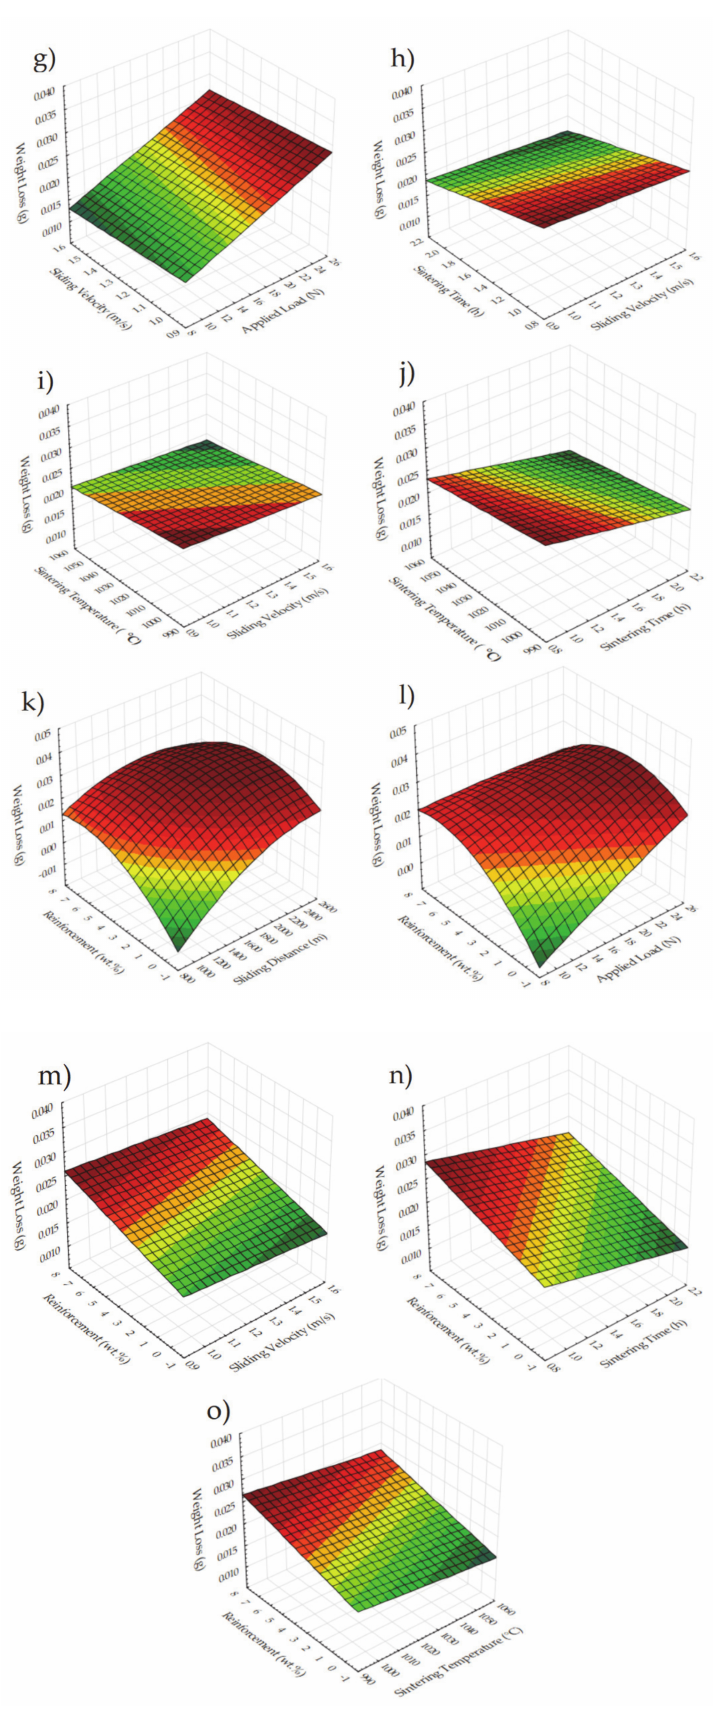
Figure 13. 3D surface plots for weight loss for the effect of ( a ) Sliding distance and applied